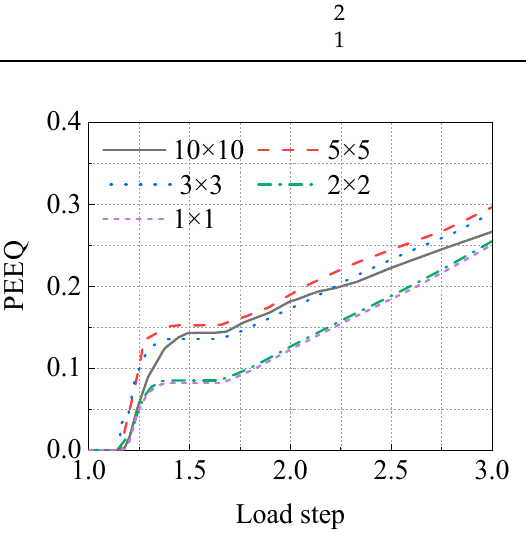
Figure 13. PEEQ comparison of center point of the internal surface with different mesh sizes.